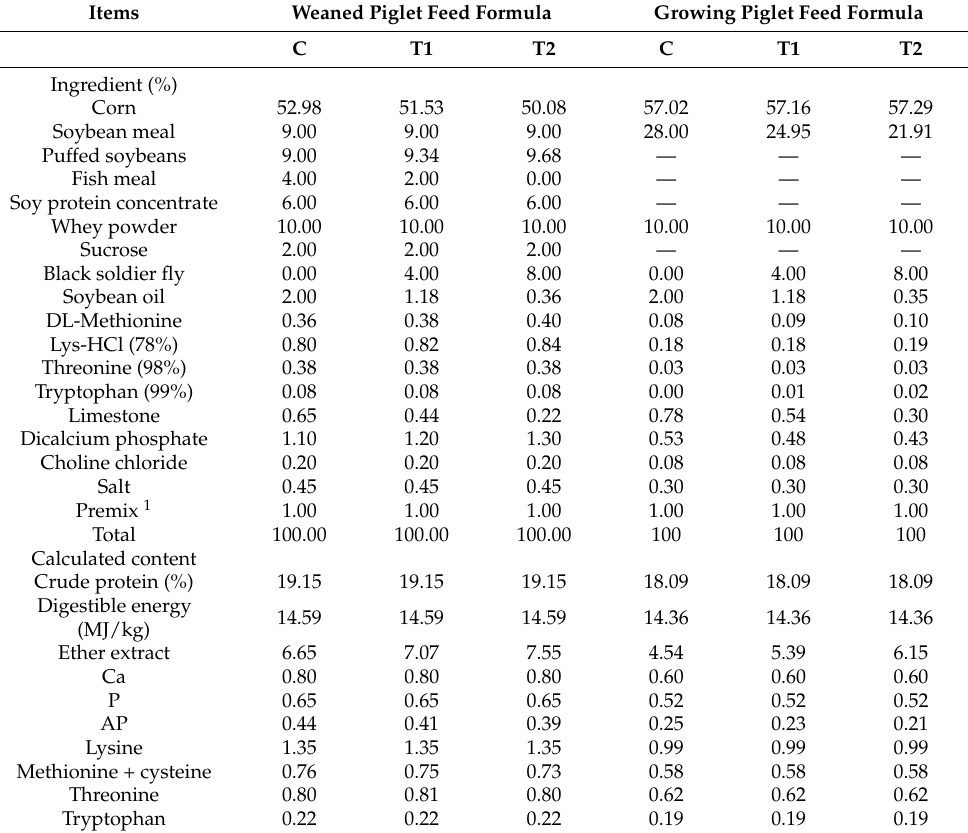
Table 1. Pig diet formula. Items Weaned Piglet Feed